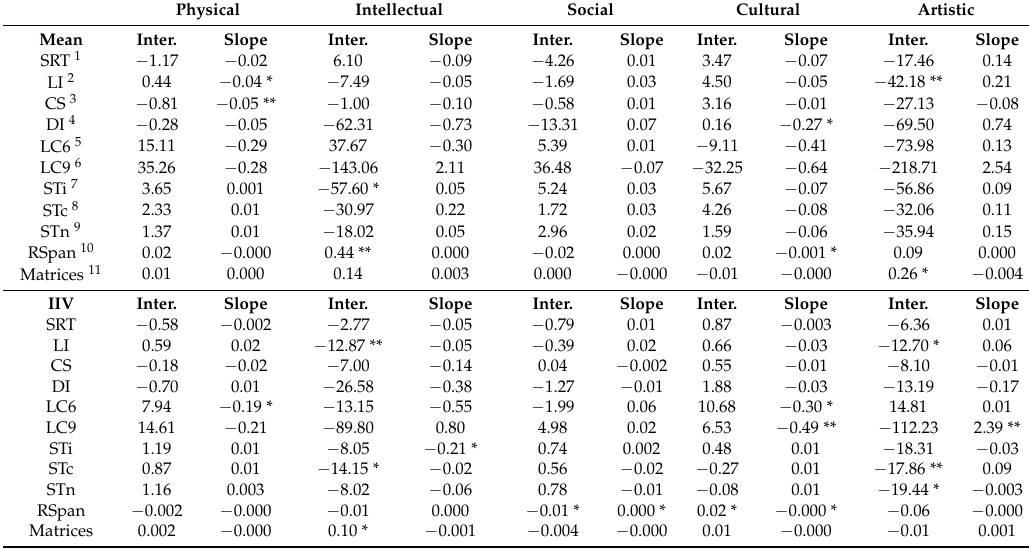
Table 3. Relationships between activity type and cognitive performance at baseline and subsequent change (mean performance and intraindividual variability (IIV)). Physical Intellectual Social Cultural